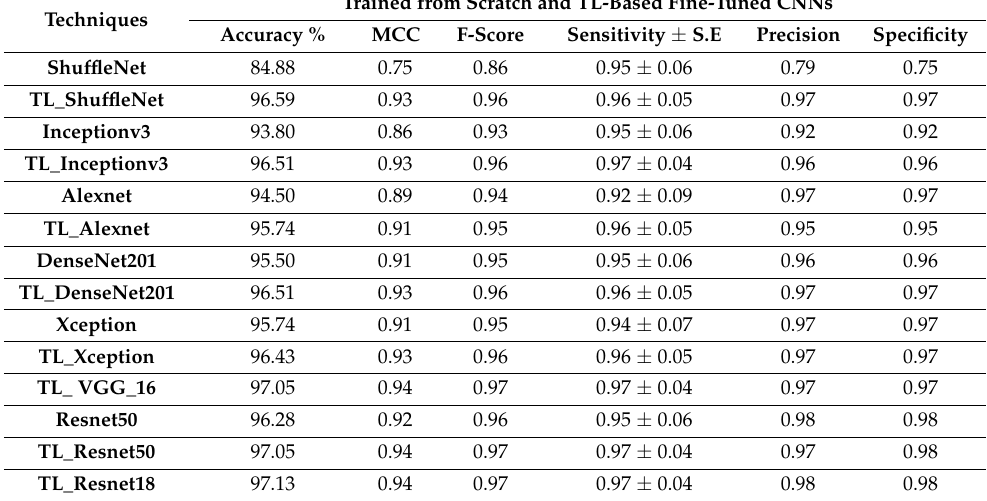
Table 4. Performance of existing CNN techniques on the test set of CoV-Healthy-6k. S.E is reported for sensitivity.